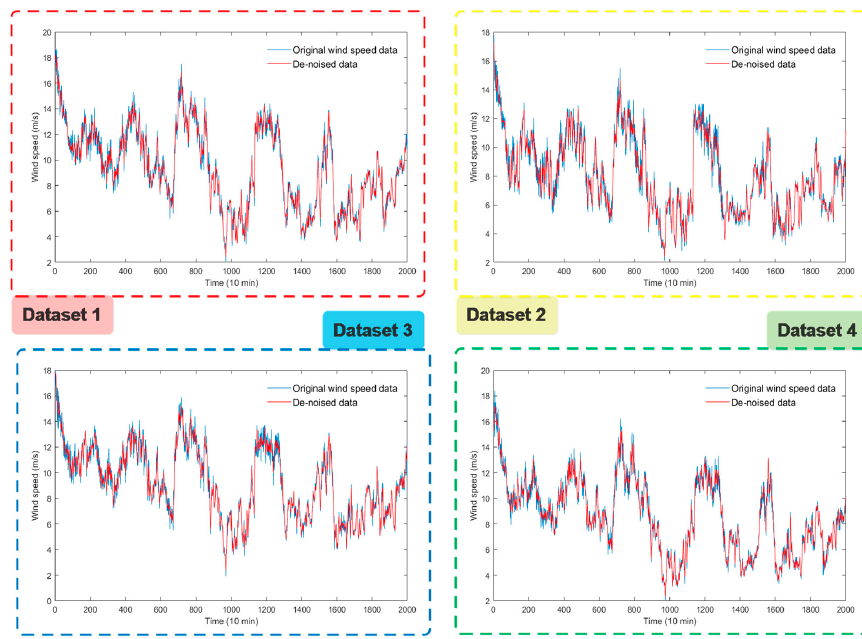
Figure 3. The original wind speed data and de-noised data from four datasets.